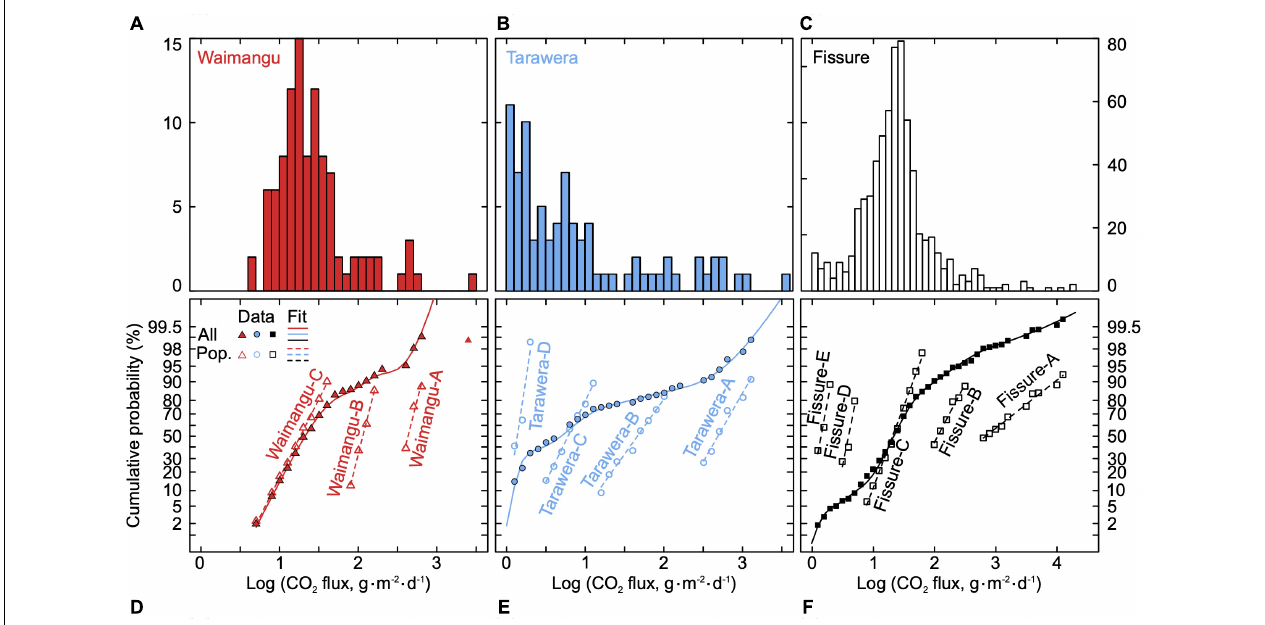
FIGURE 5 | CO 2 flux data for the 1886 fissure: histogram for (A) Waimangu, (B) Tarawera, and (C) the whole fissure (Fissure = Waimangu + Rotomahana + Tarawera); and probability plot for (D) Waimangu, (E) Tarawera, and (F) the whole fissure, where raw data are in closed symbols, populations (abbreviated to Pop.) are in open symbols (labeled according to Table 1 ), and fits are in dashed lines for populations and solid lines for all data. Waimangu data is from Hurst et al. (2006), Rotomahana data from Mazot et al. (2014), and Tarawera data from this study.